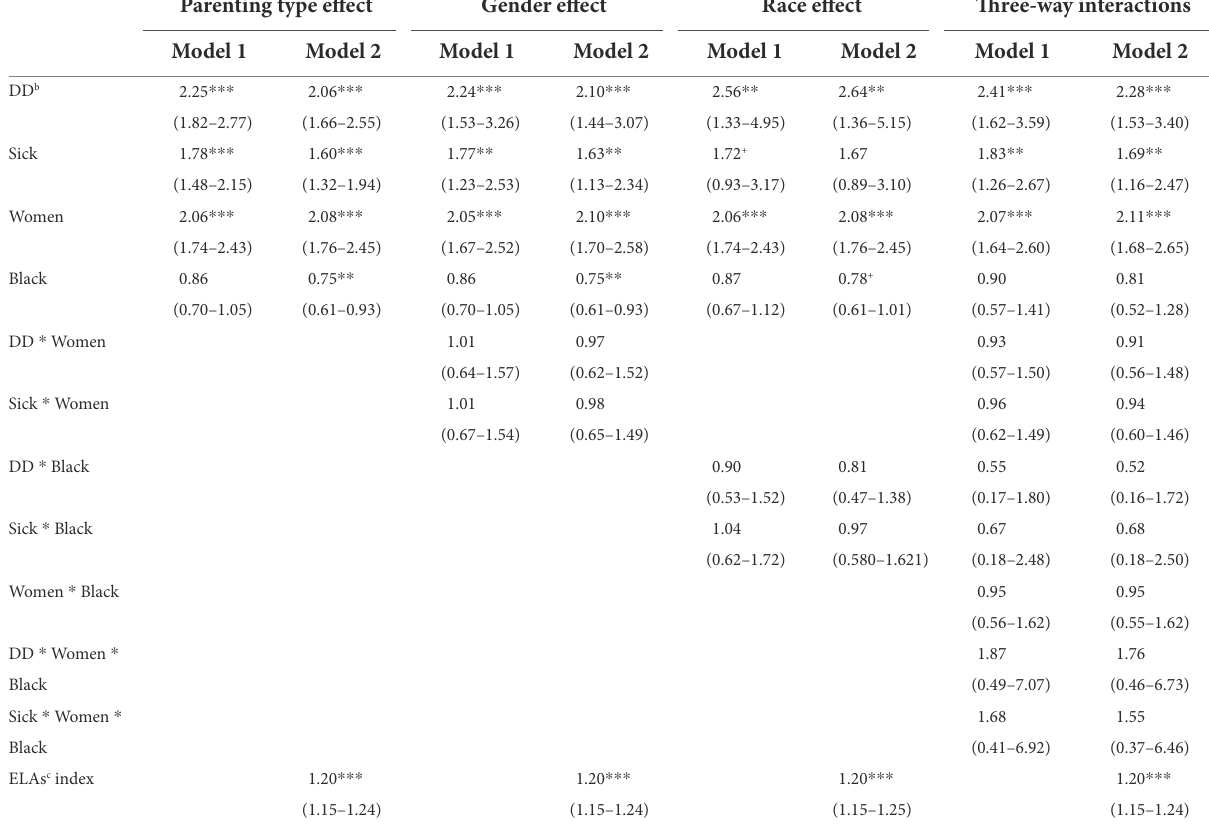
TABLE 5 Estimates of the effects of parenting type and interactions on depression (n = 7,425) a